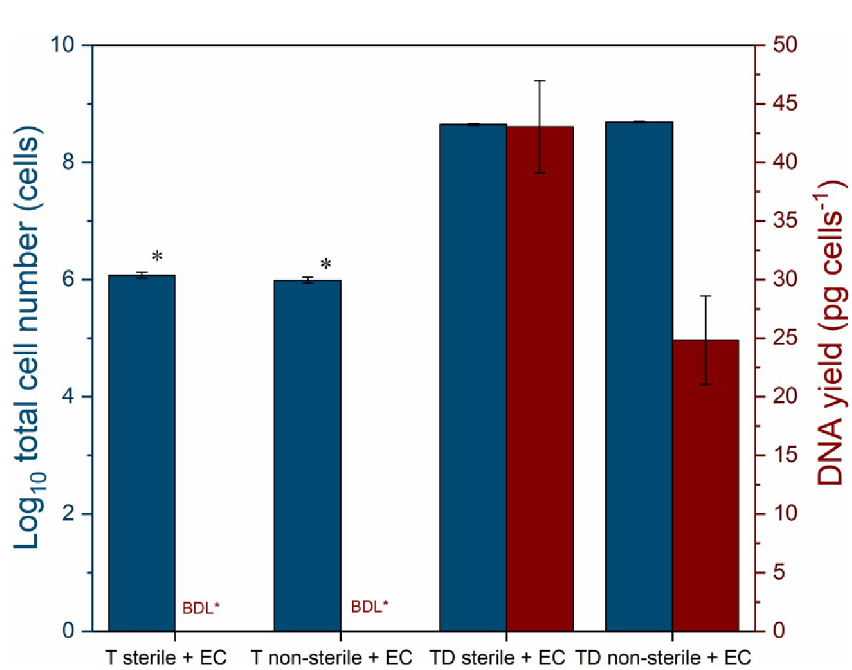
Fig 4. Total cell numbers and DNA yield obtained after Escherichia coli spiking into sterile and non-sterile (T) tap water with residual chlorine and (TD) dechlorinated tap water prior membrane filtration. The details for (sterile, non-sterile) tap water treatments used for spiking treatments are summarized in Fig 2. Sterile: Tap water was pre- filtered by membrane filtration (0.2 μ m, 47 mm diameter) before spiking. Non-sterile: Tap water without sterilization. + EC: Addition of Escherichia coli solution. A blue-coloured star indicates that total bacterial cell concentration was below the limit of detection (LOD) of flow cytometry which is 10 3 cells/mL. A red-coloured star indicates that the DNA concentration measured was below detection limit (BDL) of Qubit High Sensitivity assay dsDNA � 0.01 ng/ μ L. The error bars show errors from triplicate